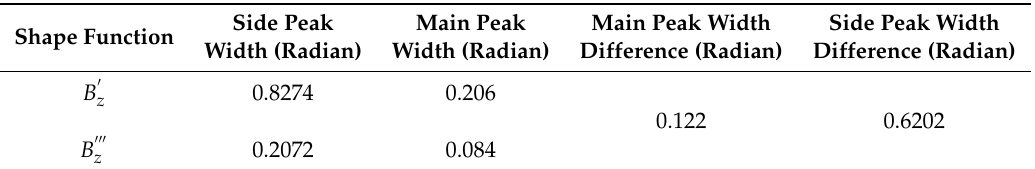
Table 1. Comparison of simulation results between 1st and 3rd order derivative. Keeping depth constant at 0.3m and radius at 2.9